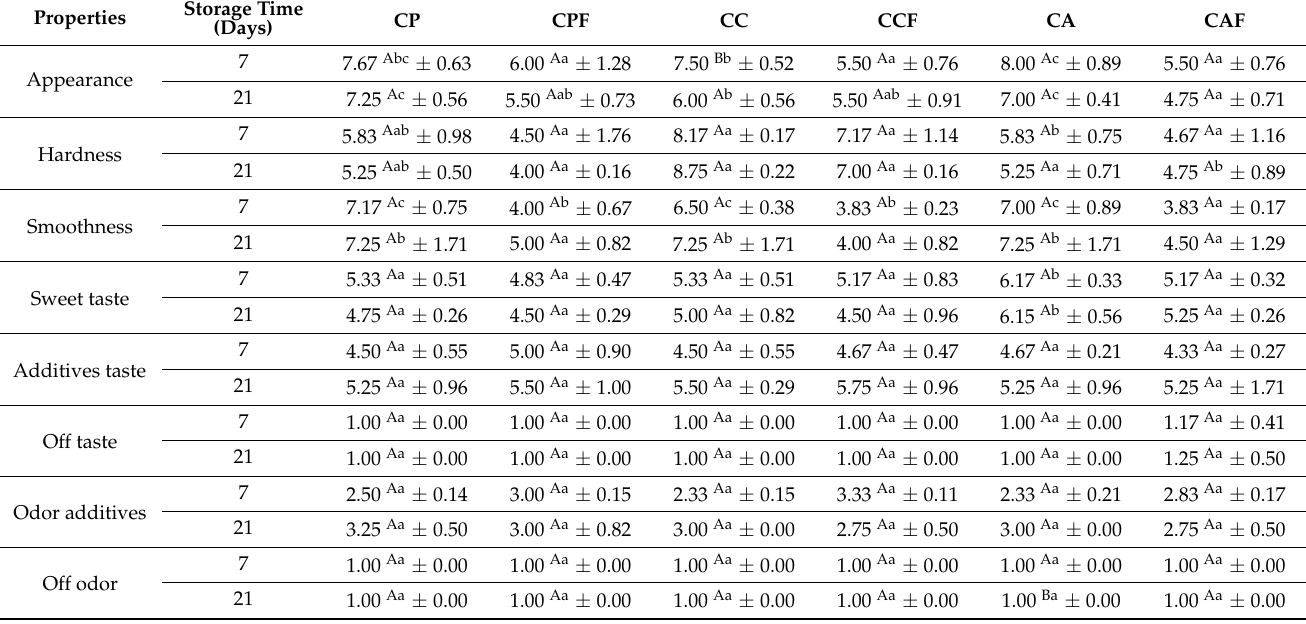
Table 7. Organoleptic characteristics of ice cream on 7 and 21 days of